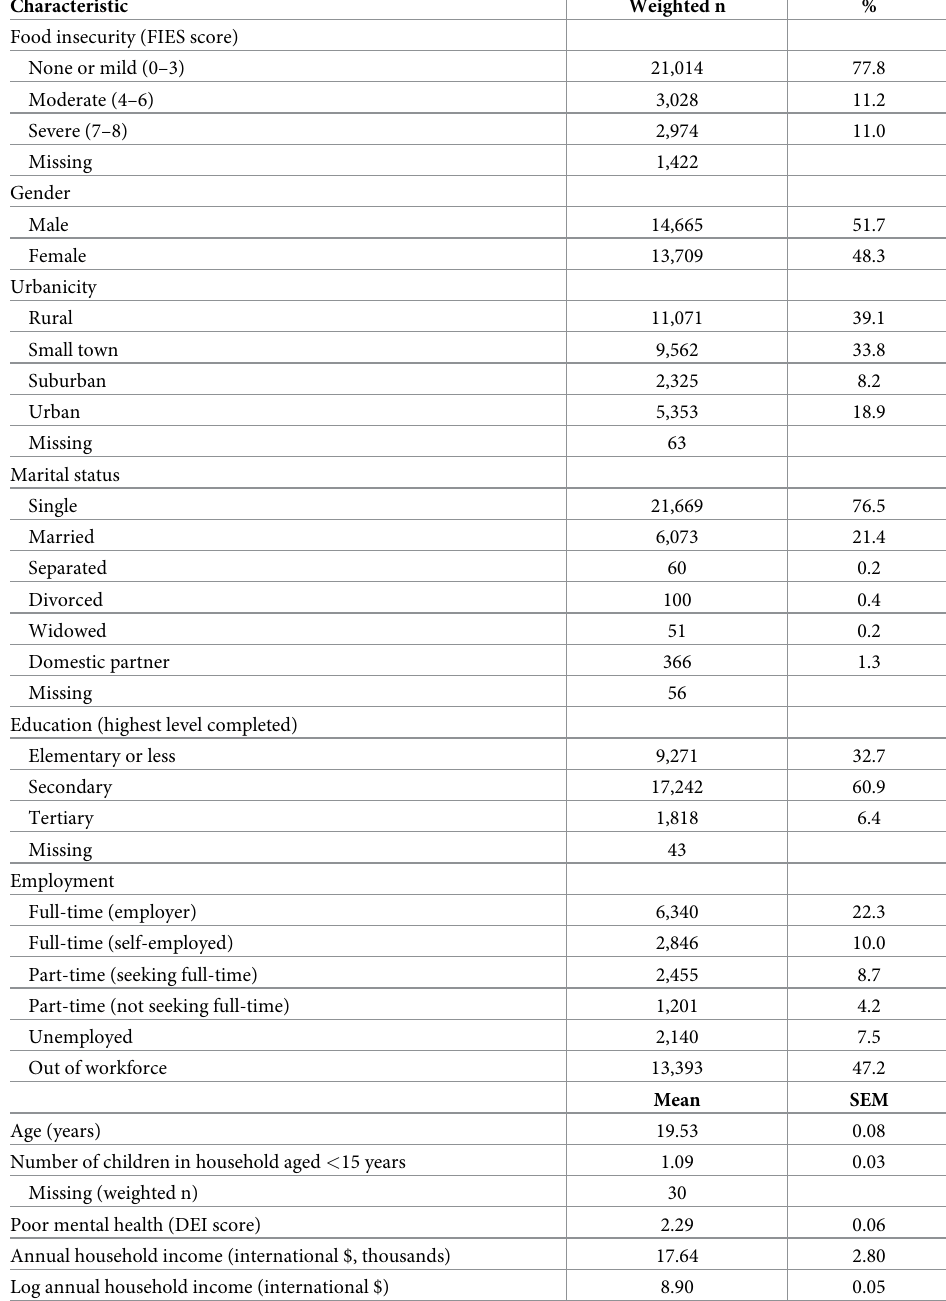
Table 1. Characteristics of the 2017 Gallup World Poll study sample (n = 28,292 youth from n = 142 countries). Descriptive estimates were based on weighted data.